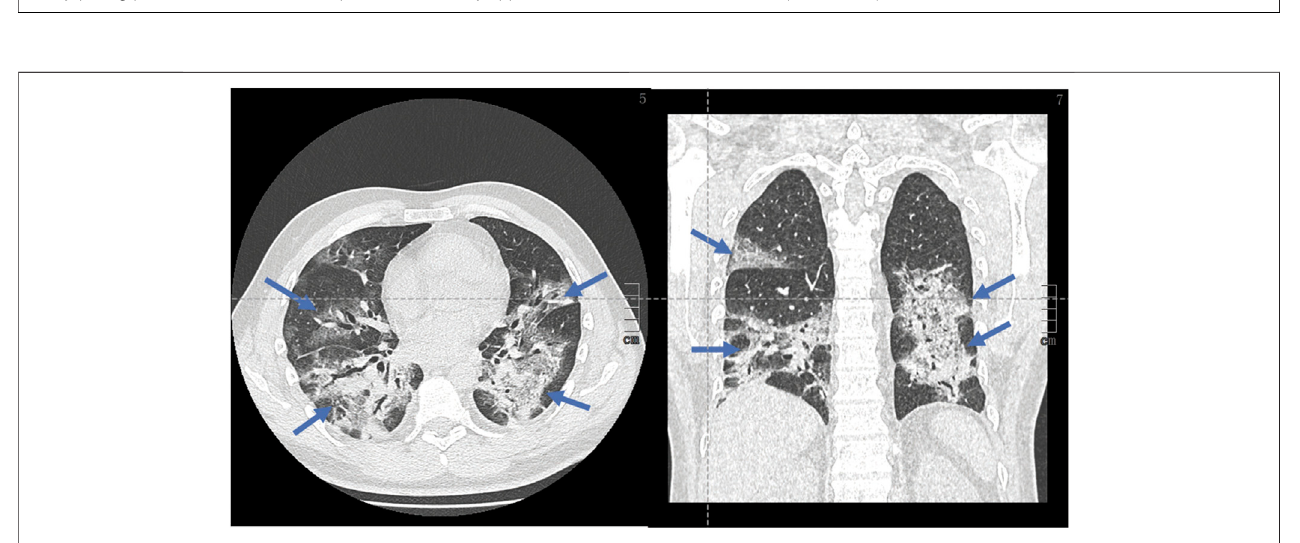
FIGURE 2 | Chest computed tomography images of patients with COVID-19 pneumonia: shows extensive abnormalities and a proportion of pulmonary condensation (blue arrows) vs. higher Ground-glass, with possible progression to pulmonary fi brosis.